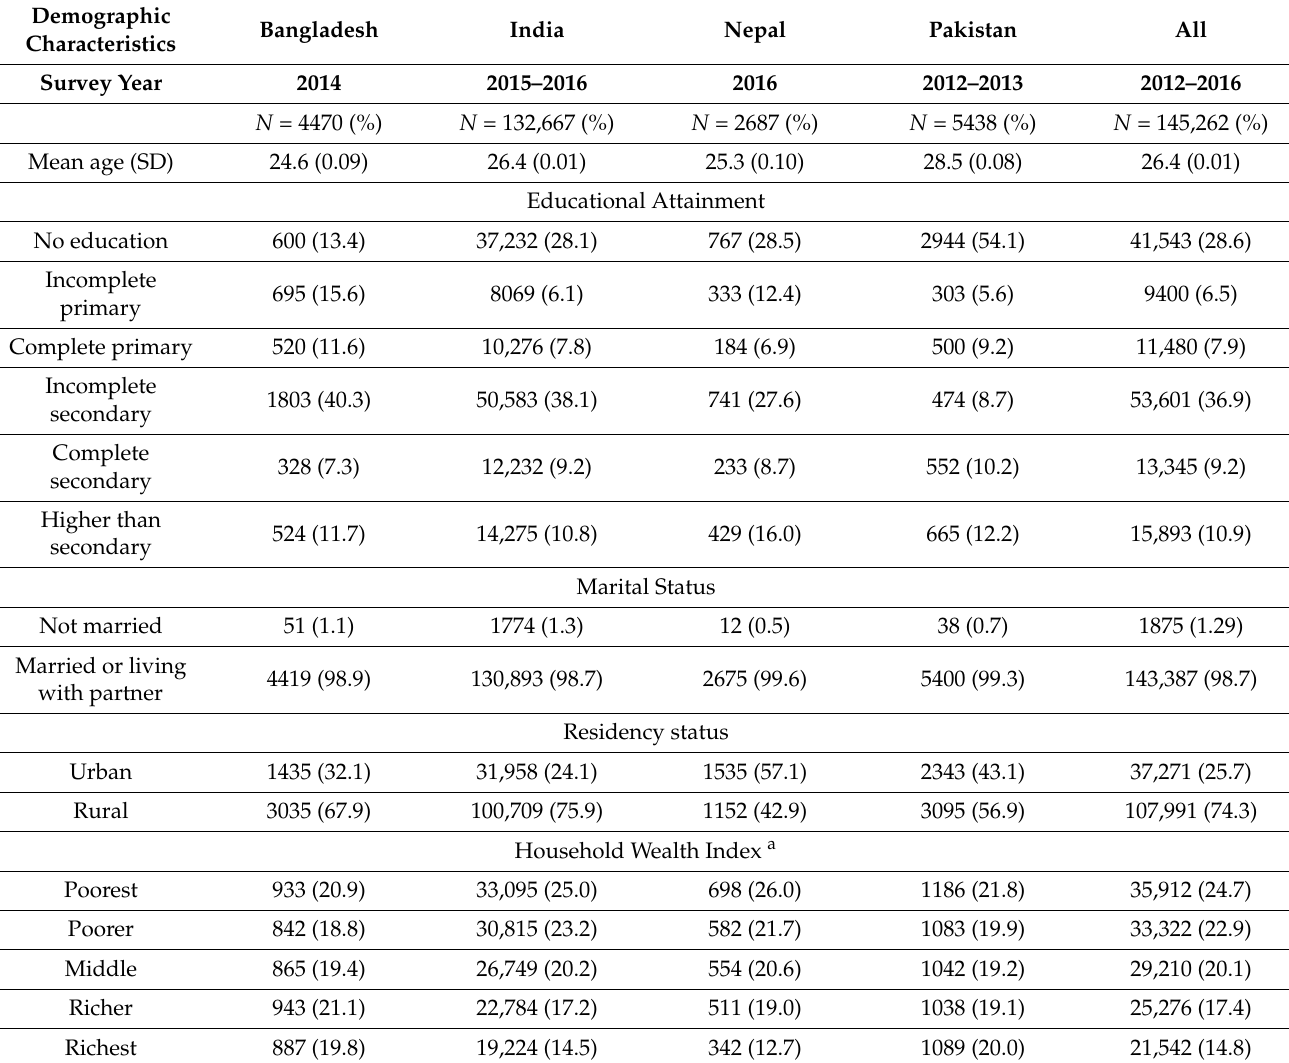
Table 2. Demographic characteristics of all women (ages 15–49 years) with children, whose last-born child is a singleton birth, alive, and between 0–36 months of age at time of interview.